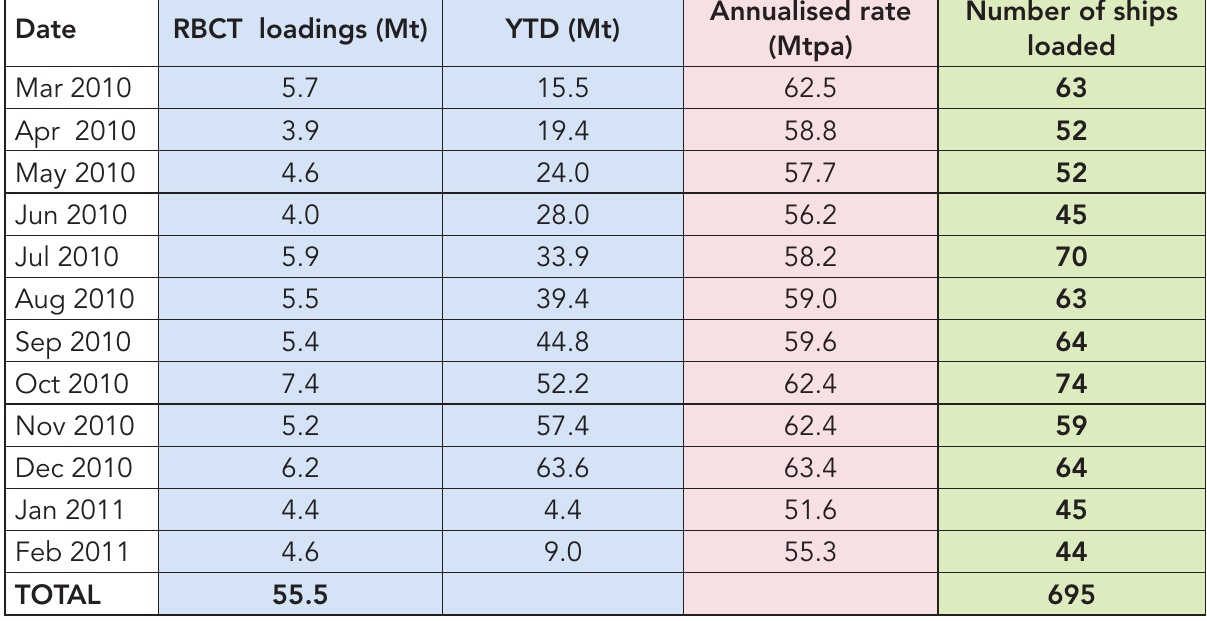
Table 4: Richards Bay Coal Terminal (RBCT) operating statistics, 2010/2011 Source: South African Coal Report,